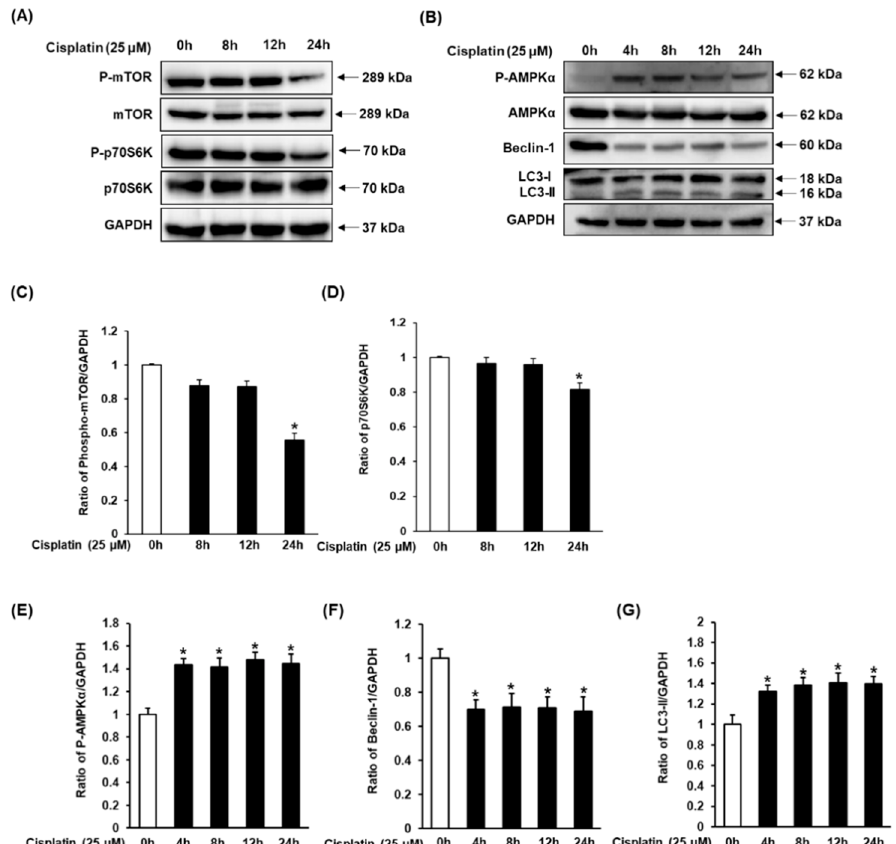
Figure 4. Time-course protein expressions of ( A ) phospho-mTOR, mTOR, phospho-p70S6K, p70S6K, and ( B ) phospho-AMPK α , AMPK α , Beclin-1, and LC3 in LLC-PK1 cells exposed to 25 µ M cisplatin by western blotting. ( C – G ) Bar graphs indicated the relative ratio of the western blot band signals in each group as compared with control cells (mean ± SD, * p < 0.05 cisplatin-treated LLC-PK1 cells). SD, standard deviation.